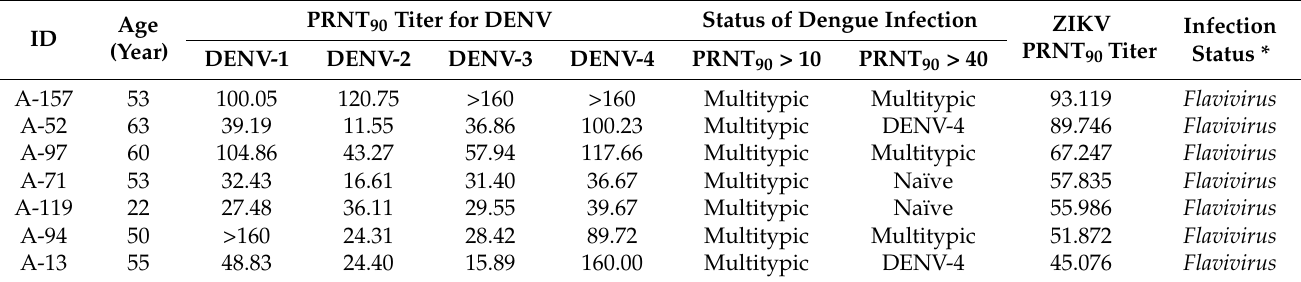
Table 2. Comparison of DENV and ZIKV NAb-positive sera for ( n =